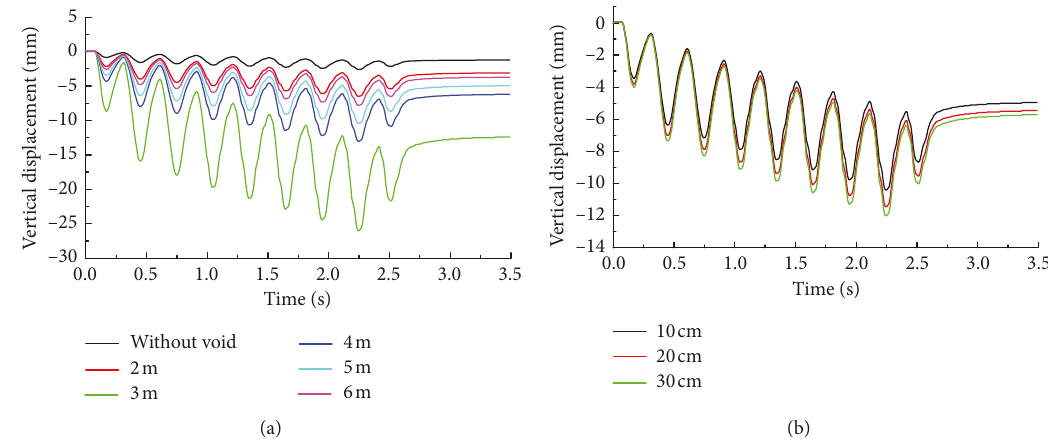
Figure 7: Time-history curves for vertical displacement of the inverted arch. (a) Vertical displacement of the inverted arch under different void widths (with a void thickness of 10cm). (b) Vertical displacement of the inverted arch under different void thicknesses (with a void width of 4m).